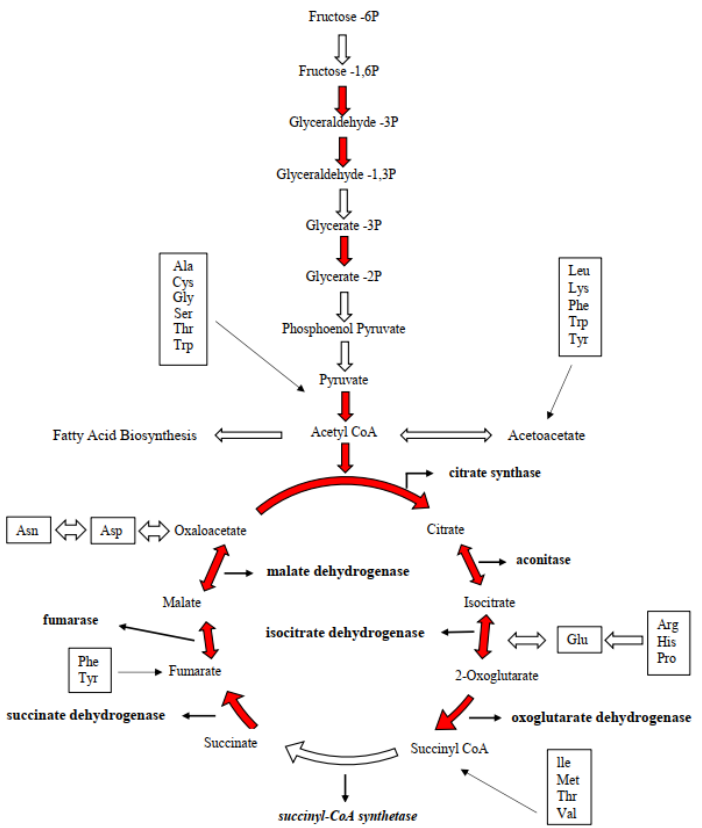
Figure 5. Representation of the changes in proteins abundance associated with carbon metabolism in S. dohrnii at the onset of silicate limitation. Increases are shown in red arrows. Boxes show where carbon skeletons from amino acid feed into the pathway.